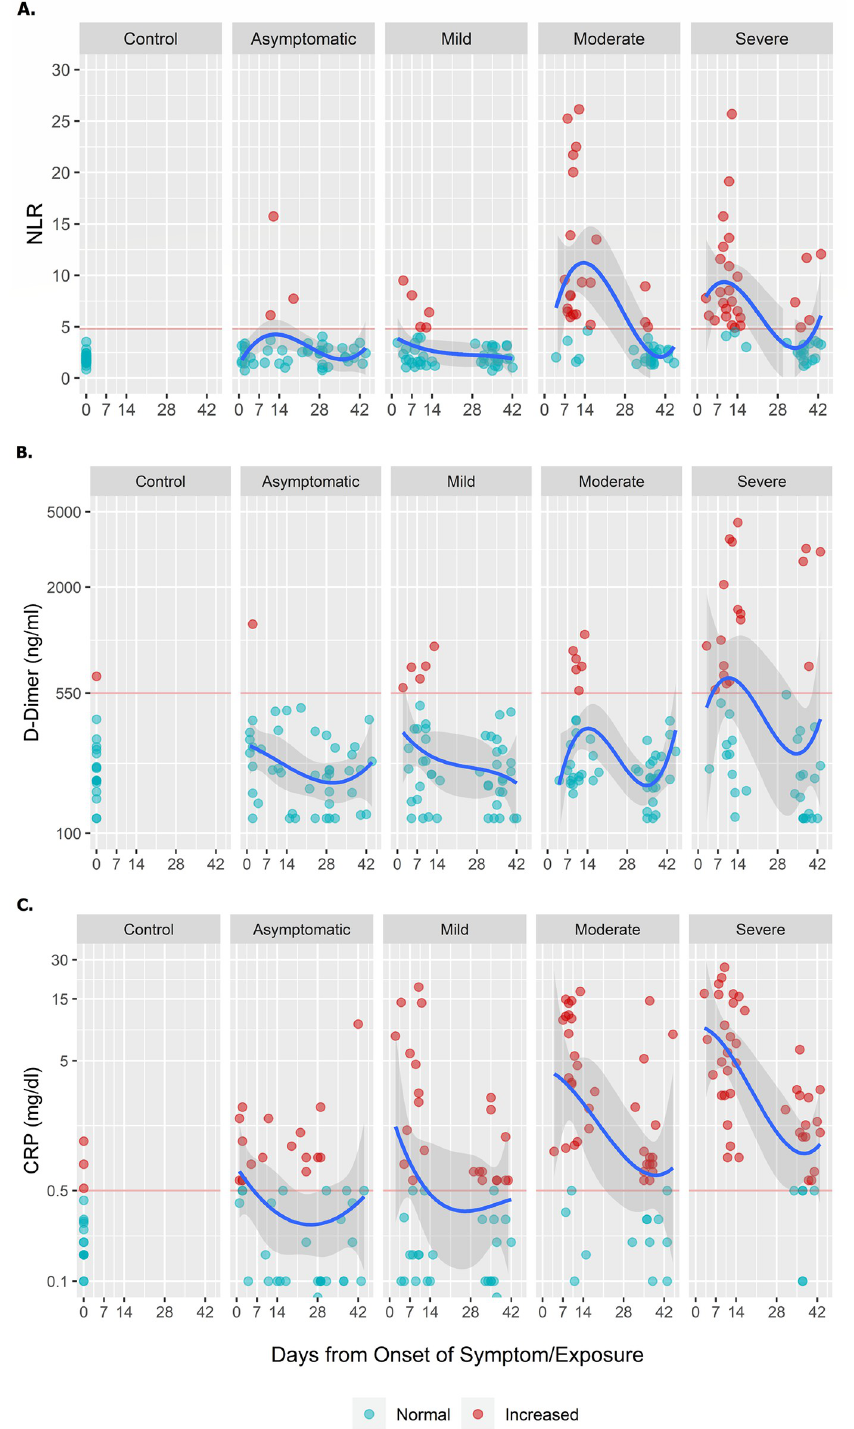
Fig 3. Trend of NLR, D-dimer and CRP among cases and controls observed over the follow-up period. All values for the symptomatic cases are measured from the date of symptom onset. Follow-up duration for asymptomatic cases are measured from the date of exposure. Healthy control participants provided samples only at one time point and values have been reported as day 0. Cut-off value for NLR was 4.795, D-Dimer is 550ng/ml and CRP is 0.5mg/dl. The blue line represents mean data over the follow-up period. Grey shaded area shows 95% CI of the mean values. Red horizontal lines reflect the normal reference values. https://doi.org/10.1371/journal.pntd.0010102.g003 PLOS NeglectedTropical Diseases | https://doi.org/10.1371/journal.pntd.0010102 January 4,